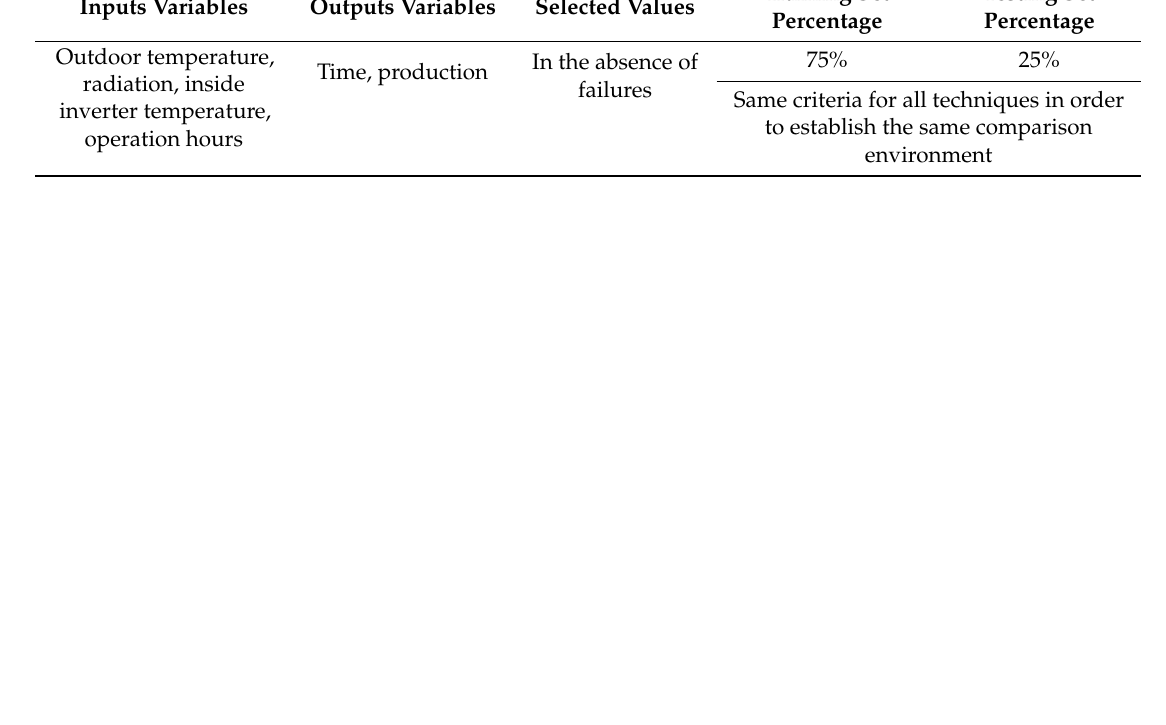
Table 3. Selected variables/data for training and validation.